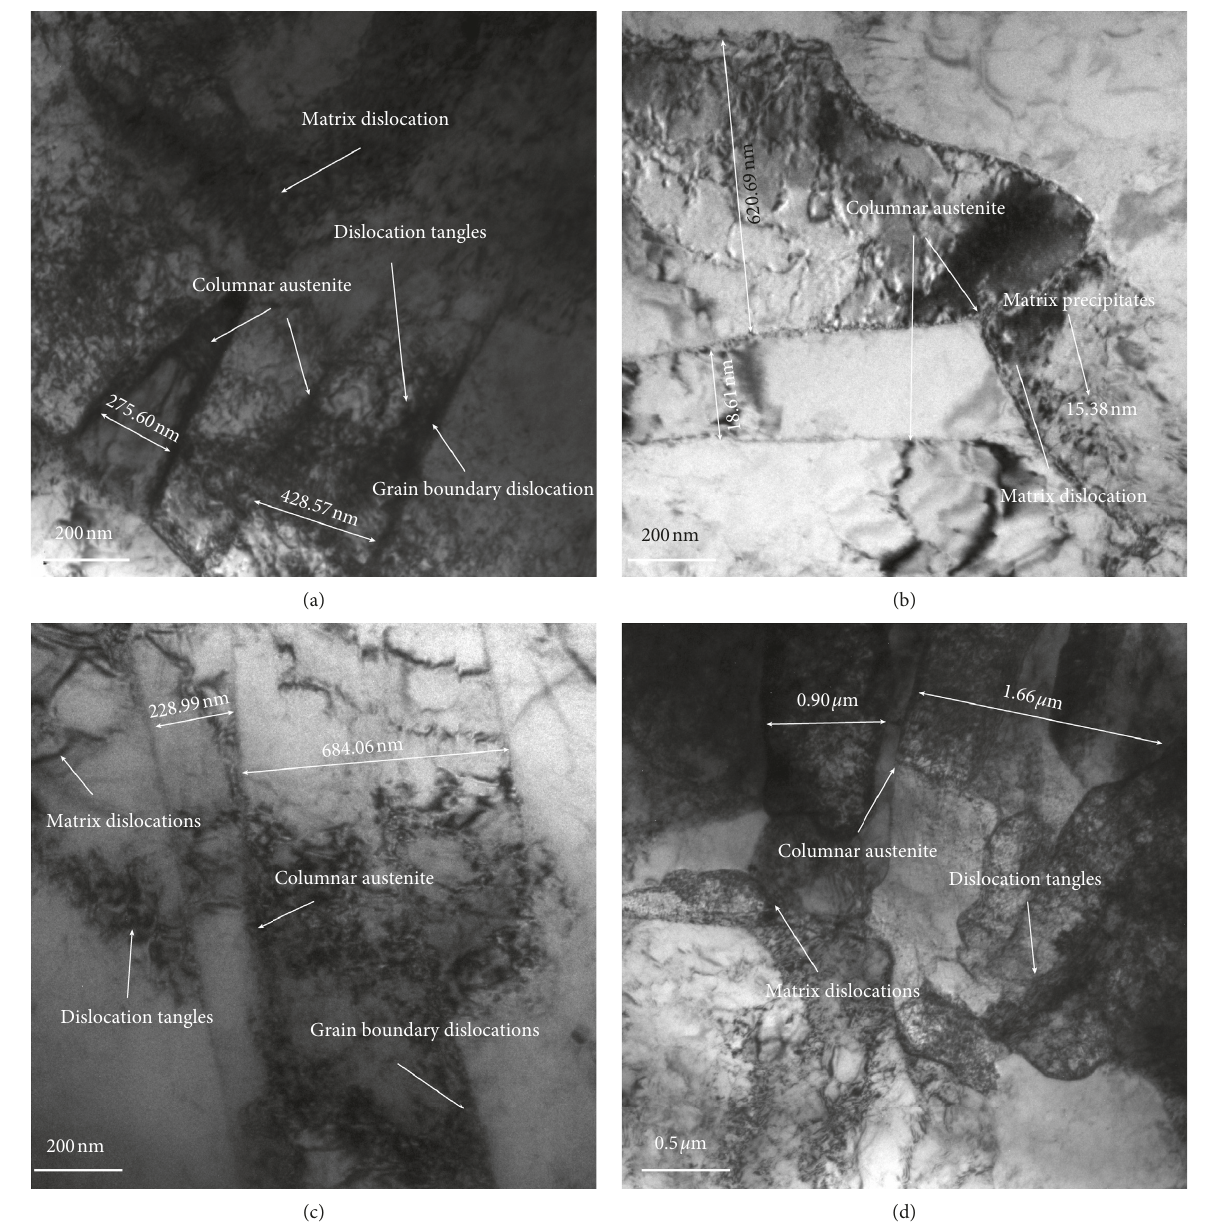
Figure 12: TEM images of near fracture zones of CTOD samples: (a, b) HAZ and (c, d)